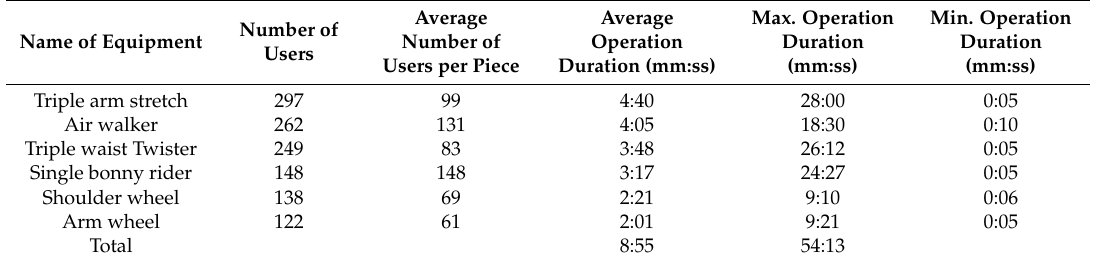
Table 3. Number of users and operation duration for individual OFE in Xihu